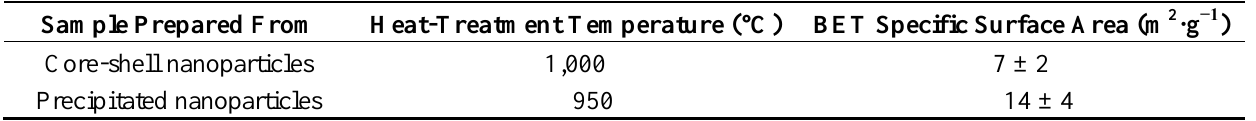
Table 2. BET specific surface areas of the cerium oxide powders obtained after heating the core-shell and the precipitated